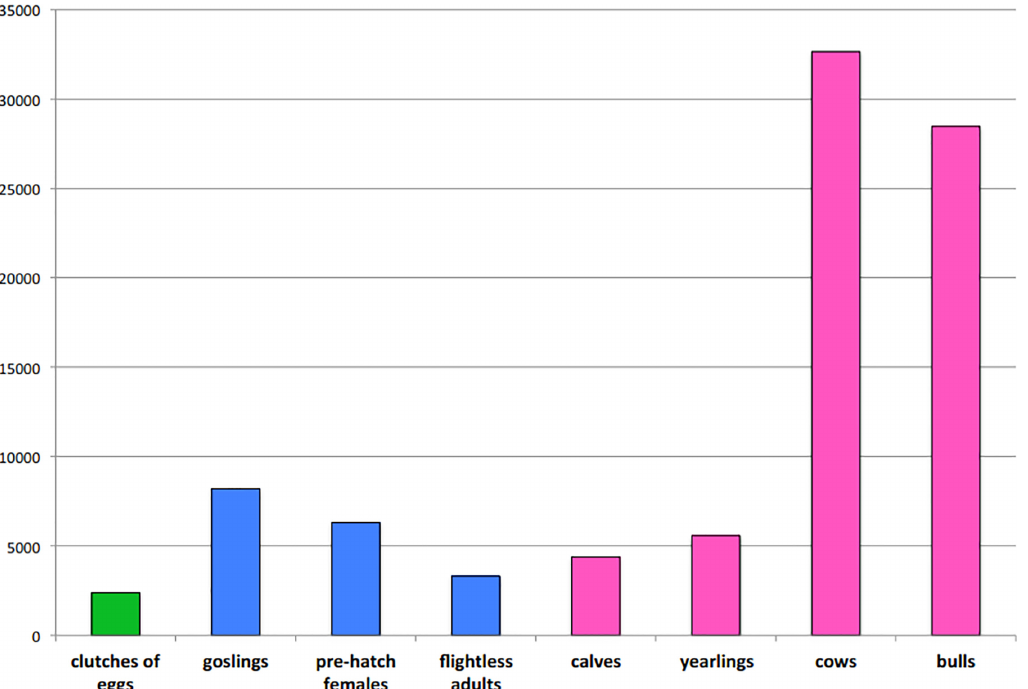
Fig 6. The maximum number of adult male polar bears projected to starve as the ice-free season expands to 180 days that could be supported by the total energy pools from each food resource. Estimates are based on 2013 population sizes of each prey and take into account somatic maintenance and daily movement costs. Values may be overestimated if true procurement costs exceed those